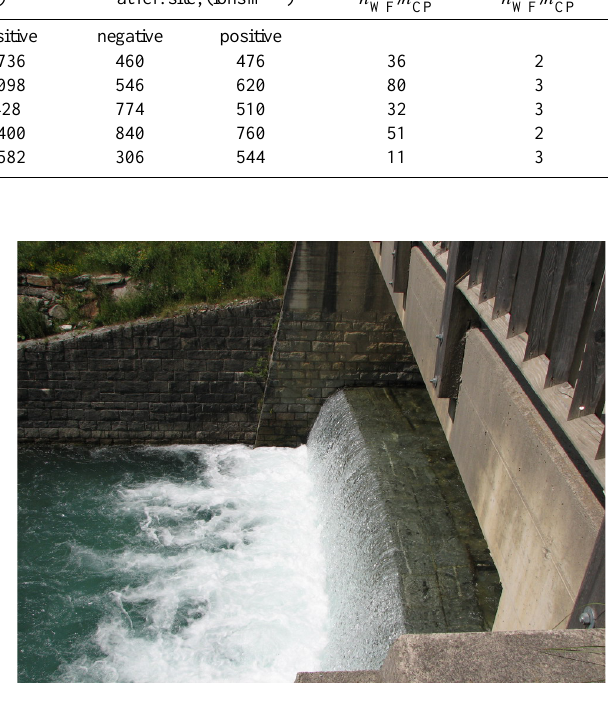
Fig. 4. Artificial WF at the river